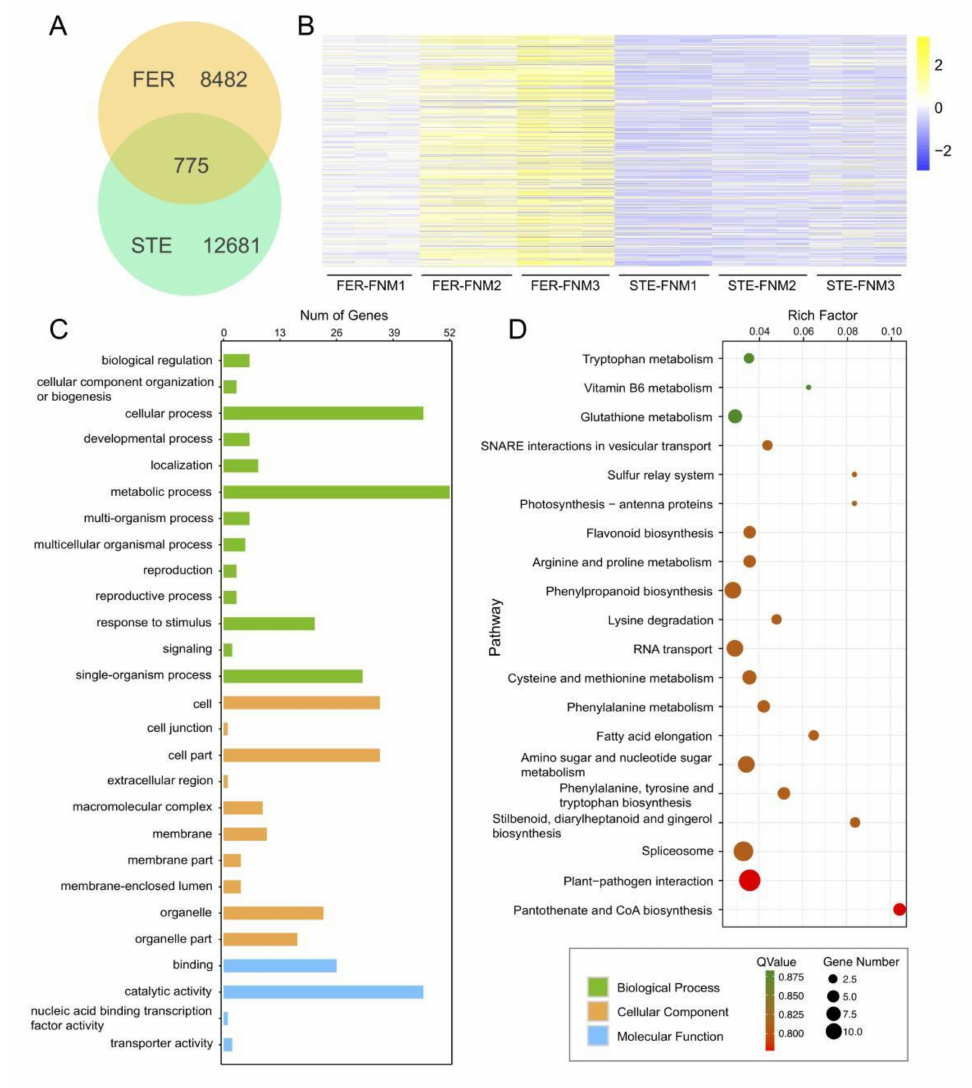
Figure 5. DEGs with opposite expression patterns during the FNM process in STE and FER; DEGs up- regulated in FER and down-regulated in STE, Venn diagram ( A ), and heat map ( B ). GO classification of DEGs with opposite expression levels ( C ). KEGG pathway enrichment of DEGs with opposite expression levels ( D